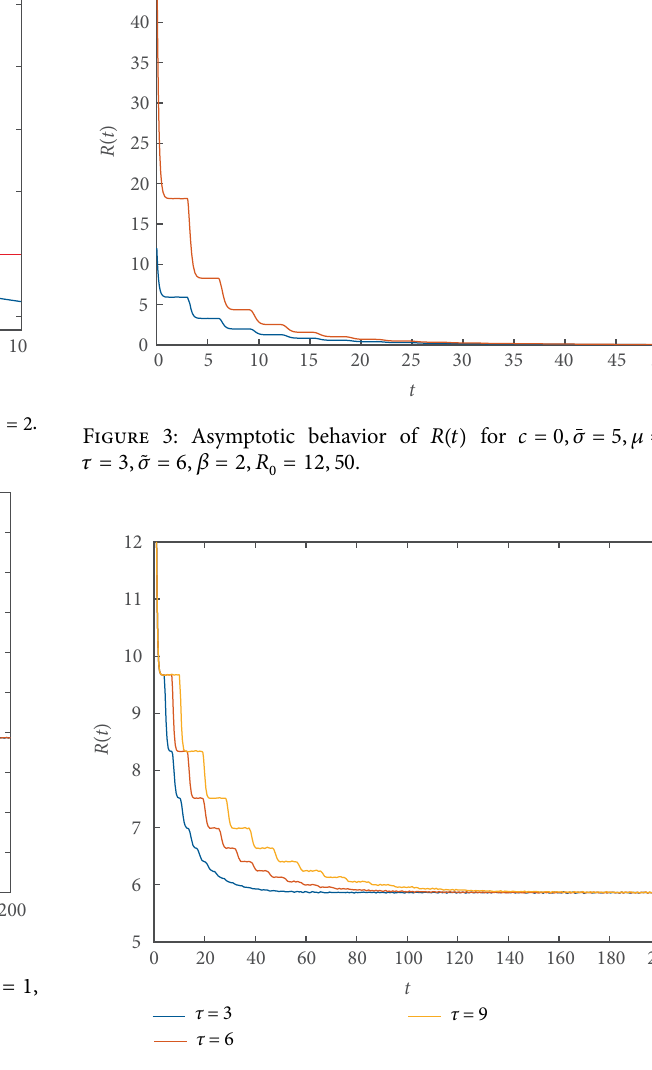
for 푐 = 0, ̄휎 = 10, 휇 = 1, 푅(푡) and 휏 = 3, 6,9